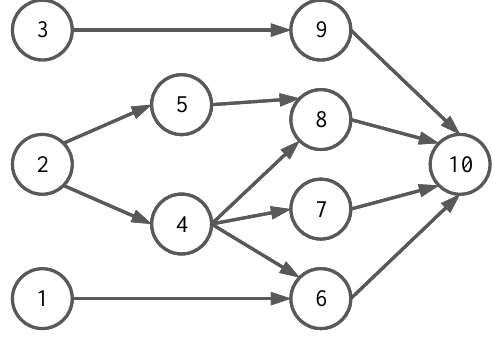
Figure 2. An example of dependency relationships among